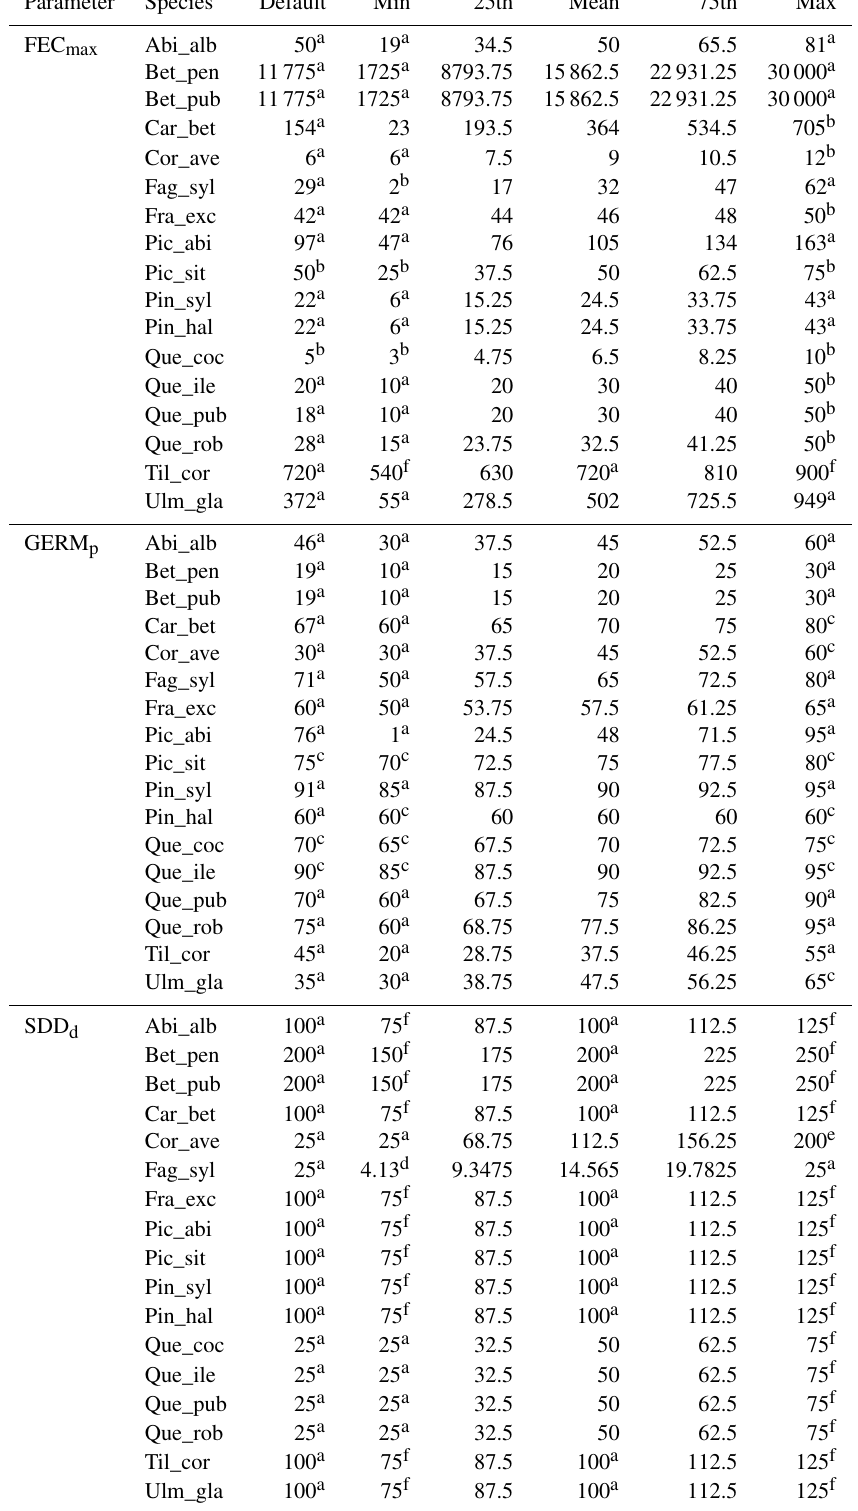
Table B2. Species-specific migration parameters and data sources for minimum and maximum values found in the literature. SDD d : average short dispersal distance (metres); LDD d : 1% average long dispersal distance (metres); FEC max : maximum fecundity per tree (no. of seeds per 100yr); GERM p : seed germination rate